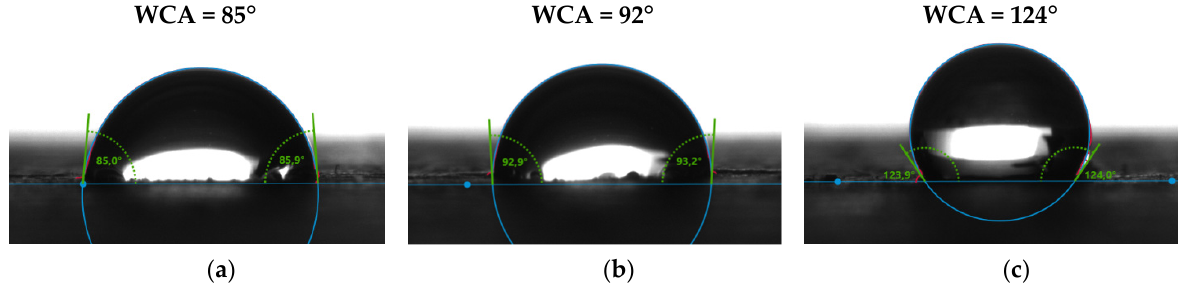
Figure 9. Water contact angle on the surfaces of coated wood obtained at c = 1.8 M, Q air = 17 L/min, and v = 30 mm/s for ( a ) 1 pass; ( b ) 2 passes; ( c ) 3 passes.